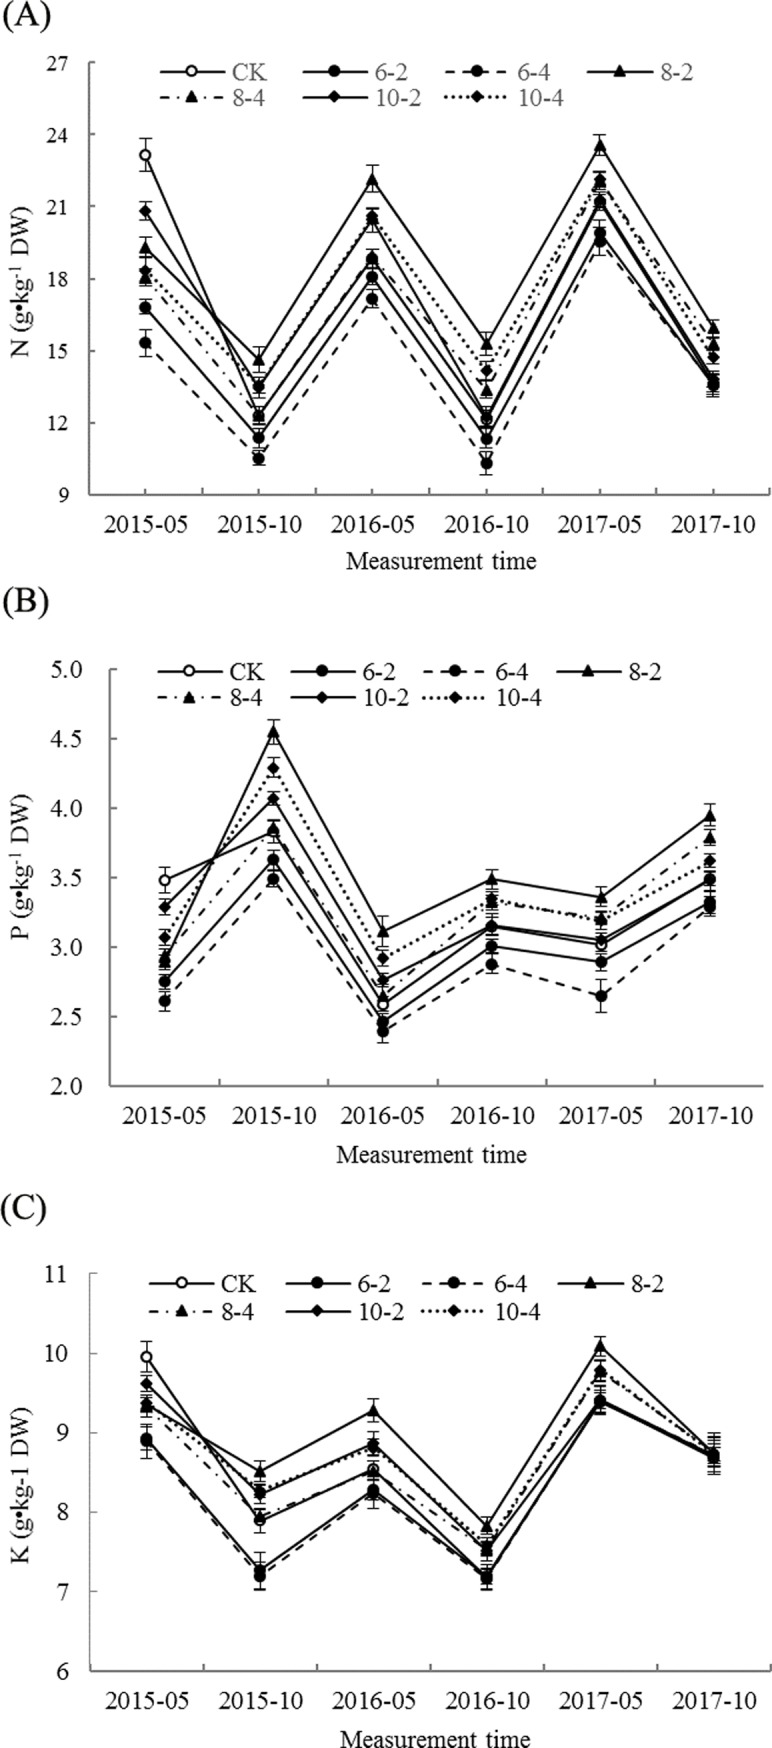
Effects of root pruning on N, P and K concentrations in poplar leaves.Bars are means and error bars are standard deviations (n = 3). (A) N concentration in poplar leaves. (B) P concentration in poplar leaves. (C) K concentration in poplar leaves.